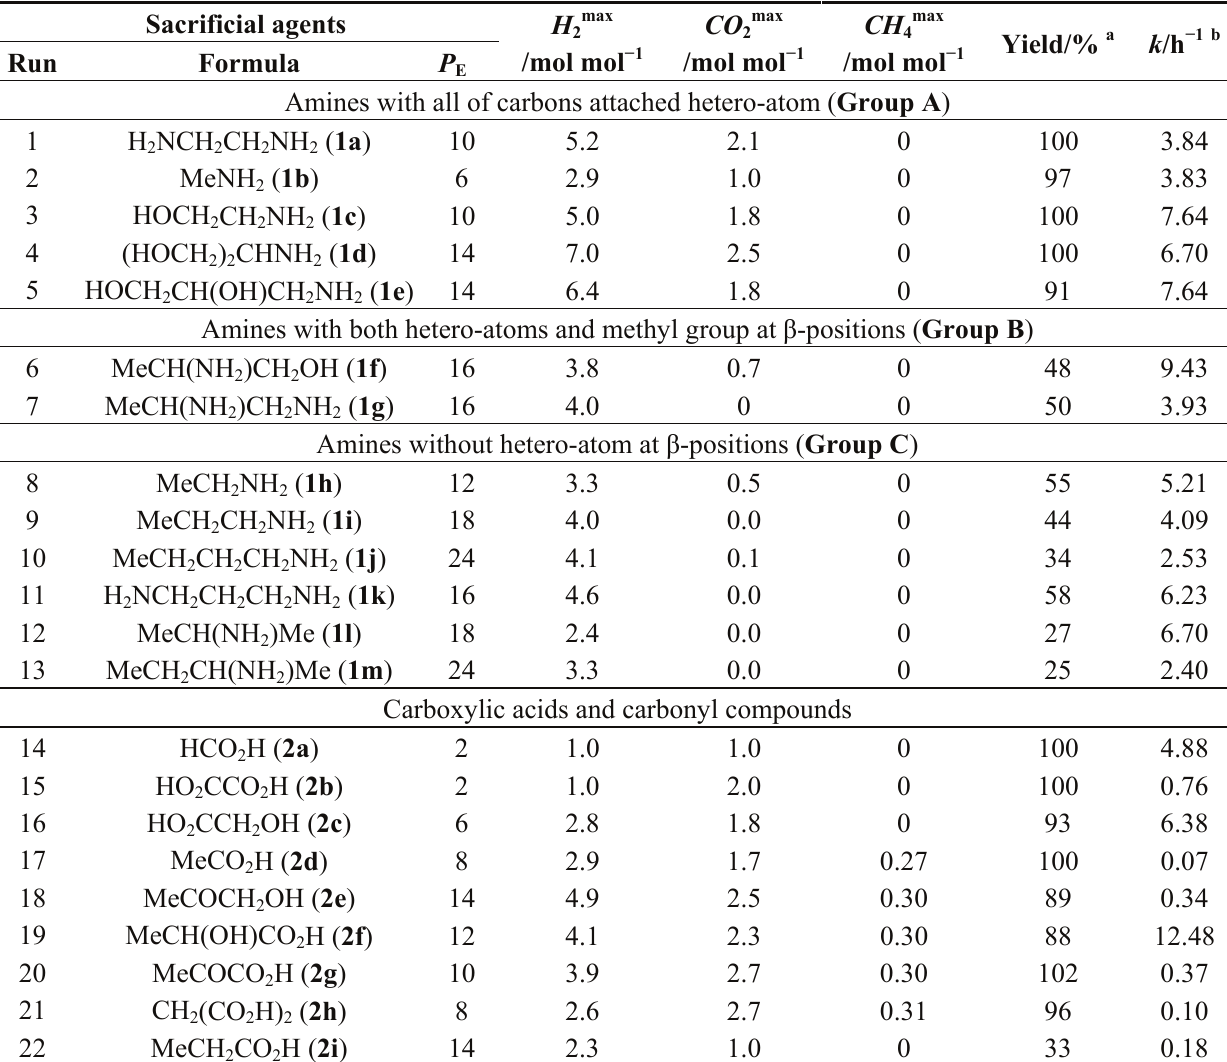
Table 1. Yields and rate constants for Pt/TiO sacrificial amines and carboxylic